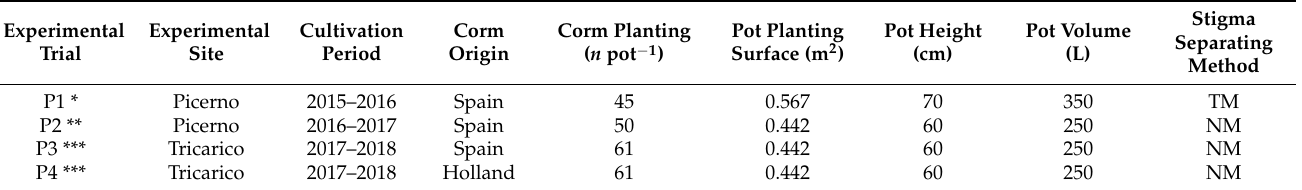
Table 1. Descriptive features of the cultivation trials in large pots and methods for obtaining the